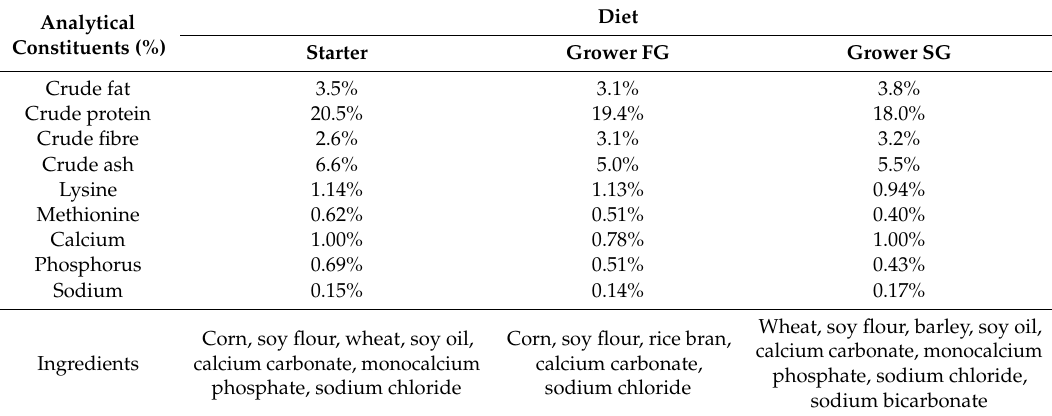
Table 1. Composition of starter and grower diets for fast-growing (FG) and slow-growing (SG) breeds. Analytical Constituents